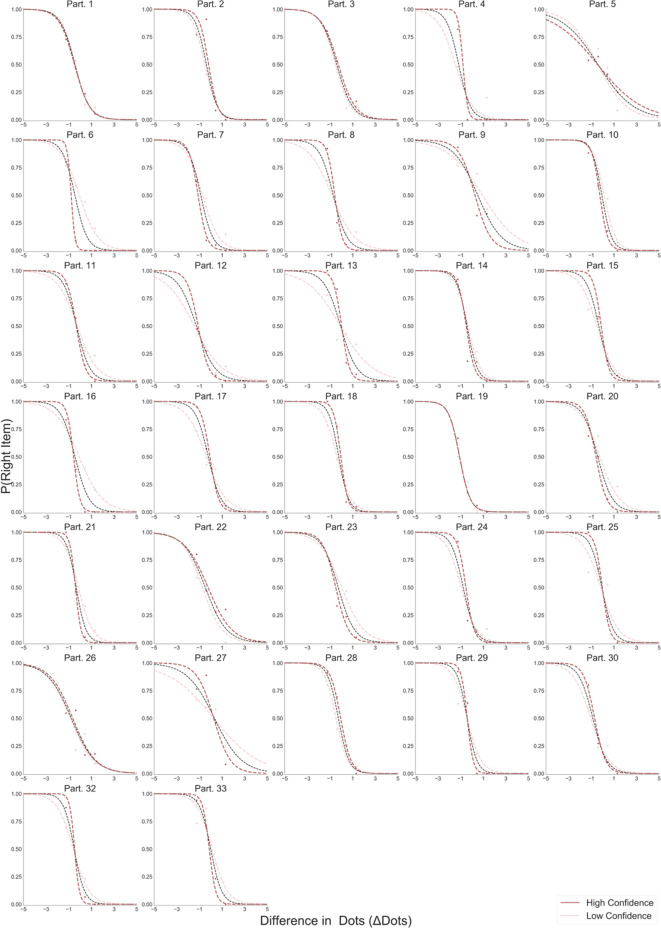
Logistic regression predicting choice from the difference in number of dots between the two circles (∆Dots).All participants in the Perceptual Experiment, fewest frame, are presented. Light red lines depict the logistic fit calculated using only low confidence trials. Dark red lines show the logistic fit only for high confidence trials. Segmented black line considers the logistic regression calculated with all the trials.